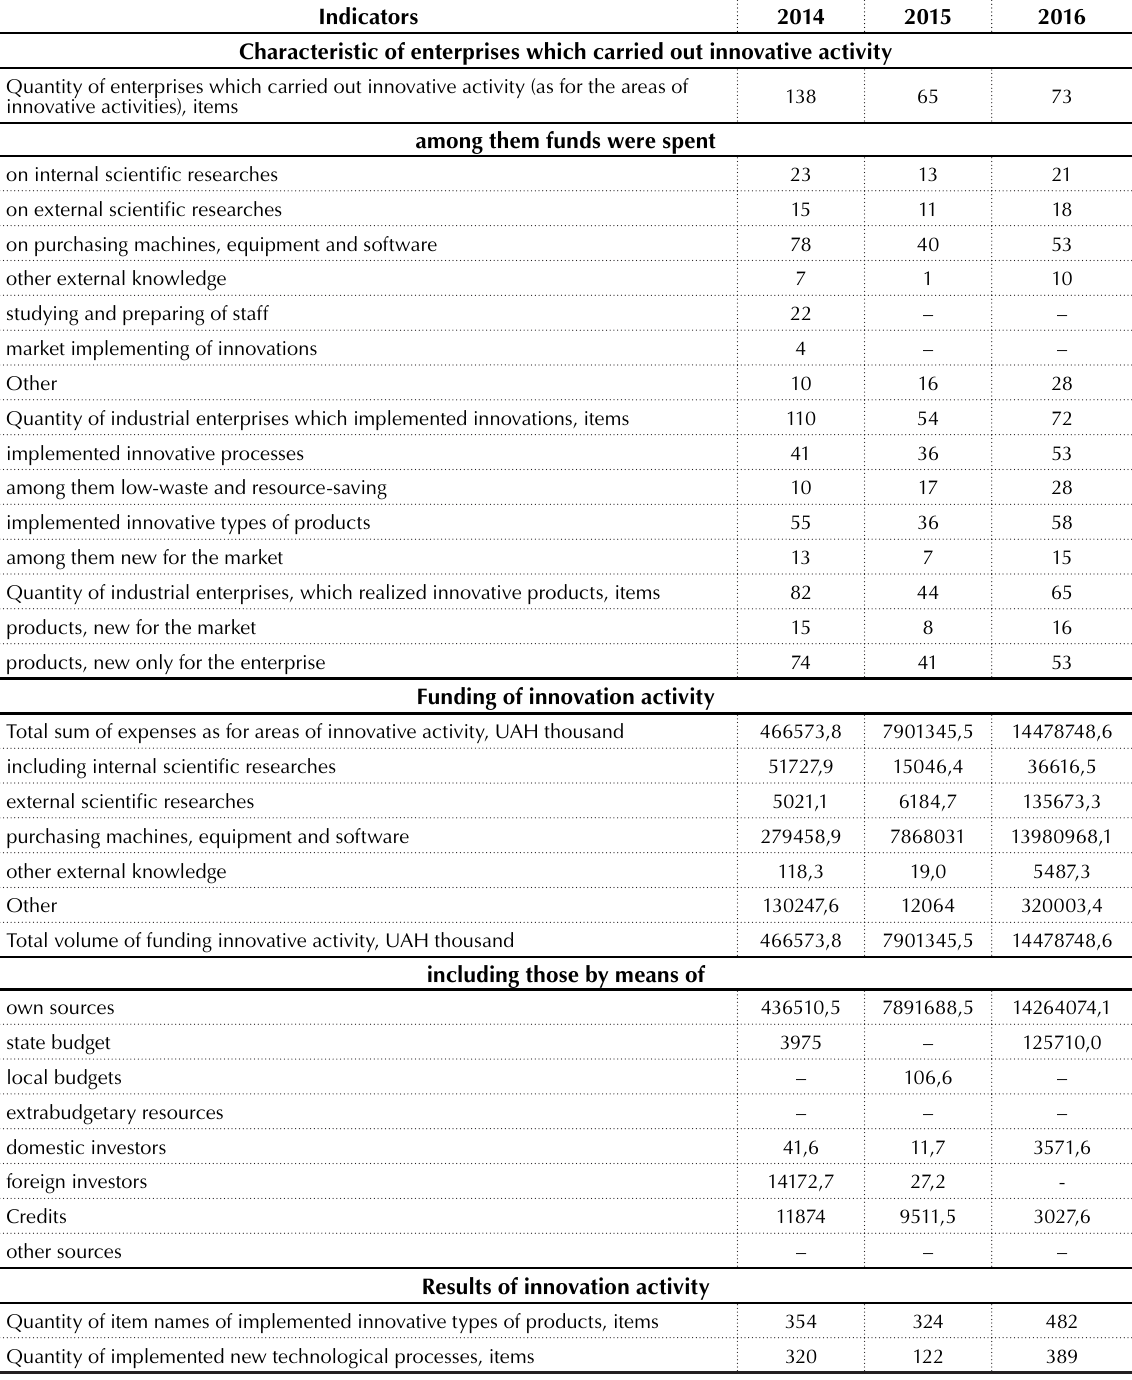
Table 4. Innovative activity of metallurgical